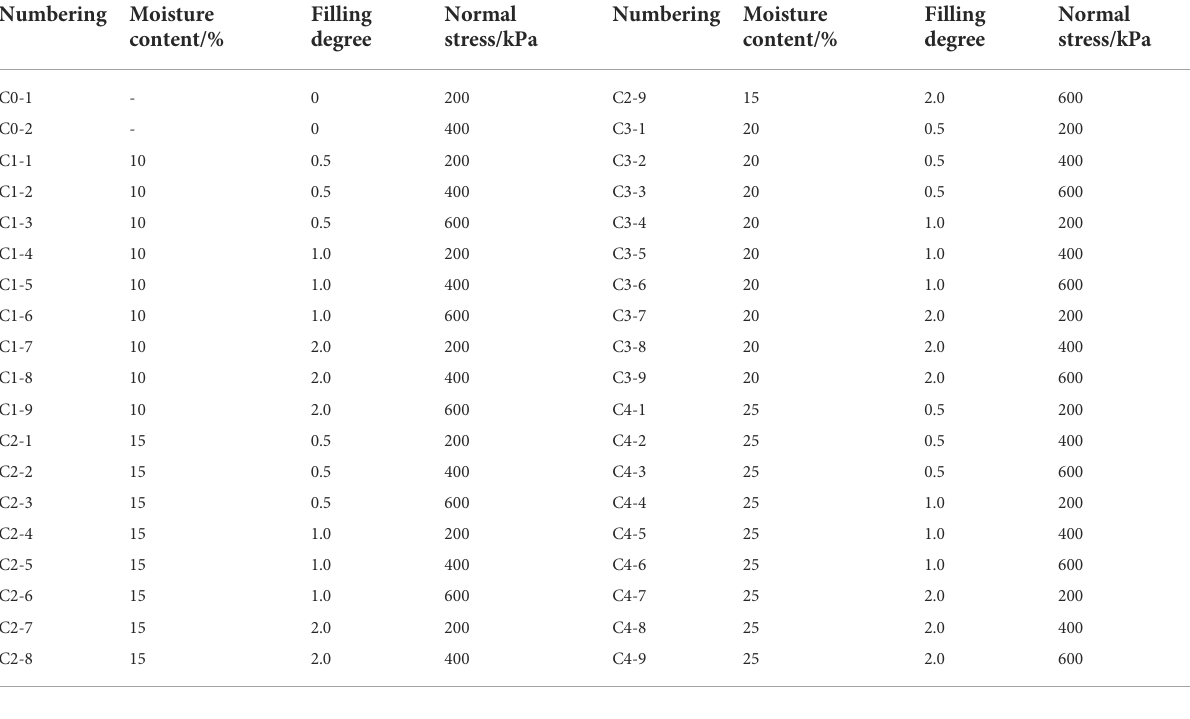
TABLE 4 Test Scheme for saw-tooth rock joint with weak interlayer.